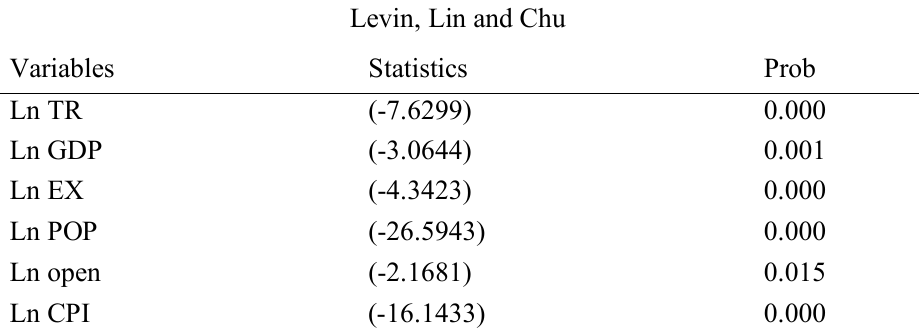
Table 2 . Results of unit root tests of model